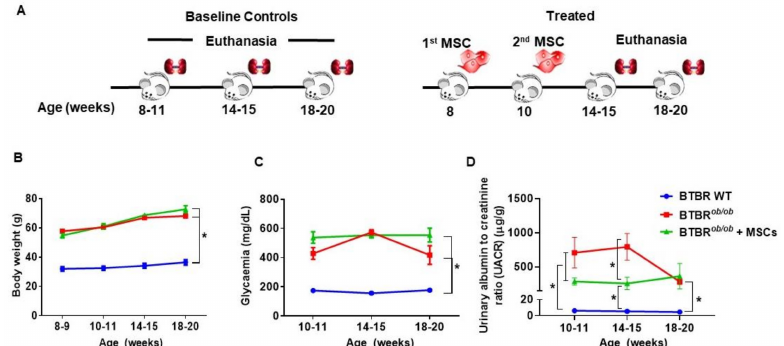
Figure 6. Metabolic and renal functional parameters in BTBR ob/ob control and MSC-treated BTBR ob/ob mice. ( A ) Schemes of the procedure. Blood and urine samples were collected at three time-points in accordance to animal age (8–11, 14–15, and 18–20 weeks old) for both BTBR ob/ob control group and MSC-treated BTBR ob/ob group. MSCs were injected in the 8th and 10th weeks of age and euthanasia was performed in the 18th–20th weeks of age. ( B ) Body weight gain in BTBR ob/ob was not prevented by MSC treatment ( p > 0.05). ( C ) Glycemia after 6 h-starvation did not decrease after MSC treatment ( p > 0.05). ( D ) Urine-albumin-to-creatinine ratio (UACR) was significantly diminished in MSC-treated BTBR ob/ob mice in the 14th week of age when compared to BTBR ob/ob control mice (* p < 0.05). Error bars represent mean ± SEM; n = 6 animals.